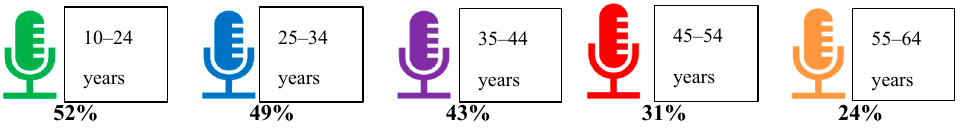
Figure 1. Search by voice or voice commands in a month. Source: own elaboration with Hootsuite 2020 data.